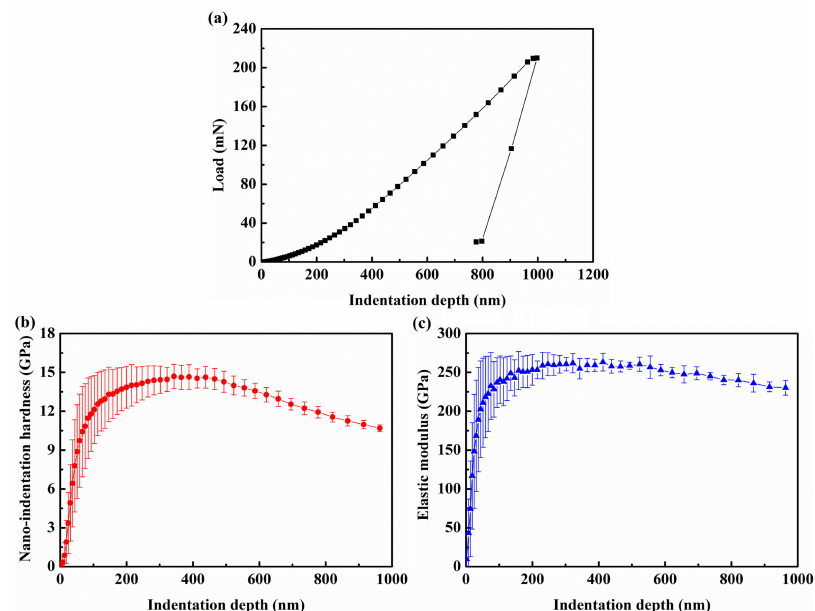
Figure 3. Nano-indentation tests of HCPEB-treated Ta coating: ( a ) load–displacement curve; ( b ) hardness with standard deviation; ( c ) elastic modulus with standard deviation.